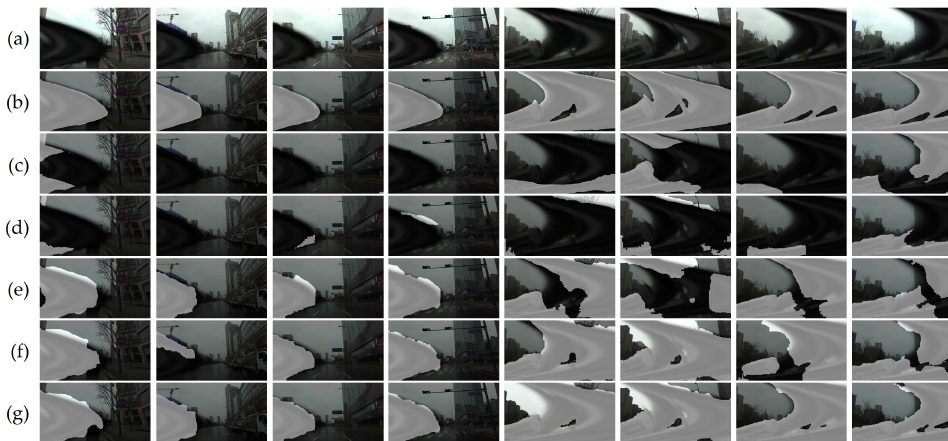
Figure 12. Qualitative results in data synthesis scenario: ( a ) original images; ( b ) ground truth wiper masks; wiper detection results by ( c ) raft-sintel; ( d ) raft-things; fine-tuned with scenario of ( e ) sequential sequence scenario; ( f ) random; ( g ) random sequence (BTS). ( c , d ) models were trained with the original Sintel dataset, while ( e – g ) models fine-tuned the reference model, raft-things, with various synthesis scenarios. BTS copes with the intractable severely distorted object resulting from the fast speeds of wipers. The results show the effectiveness of data diversity by our data synthesis strategies. Best viewed with